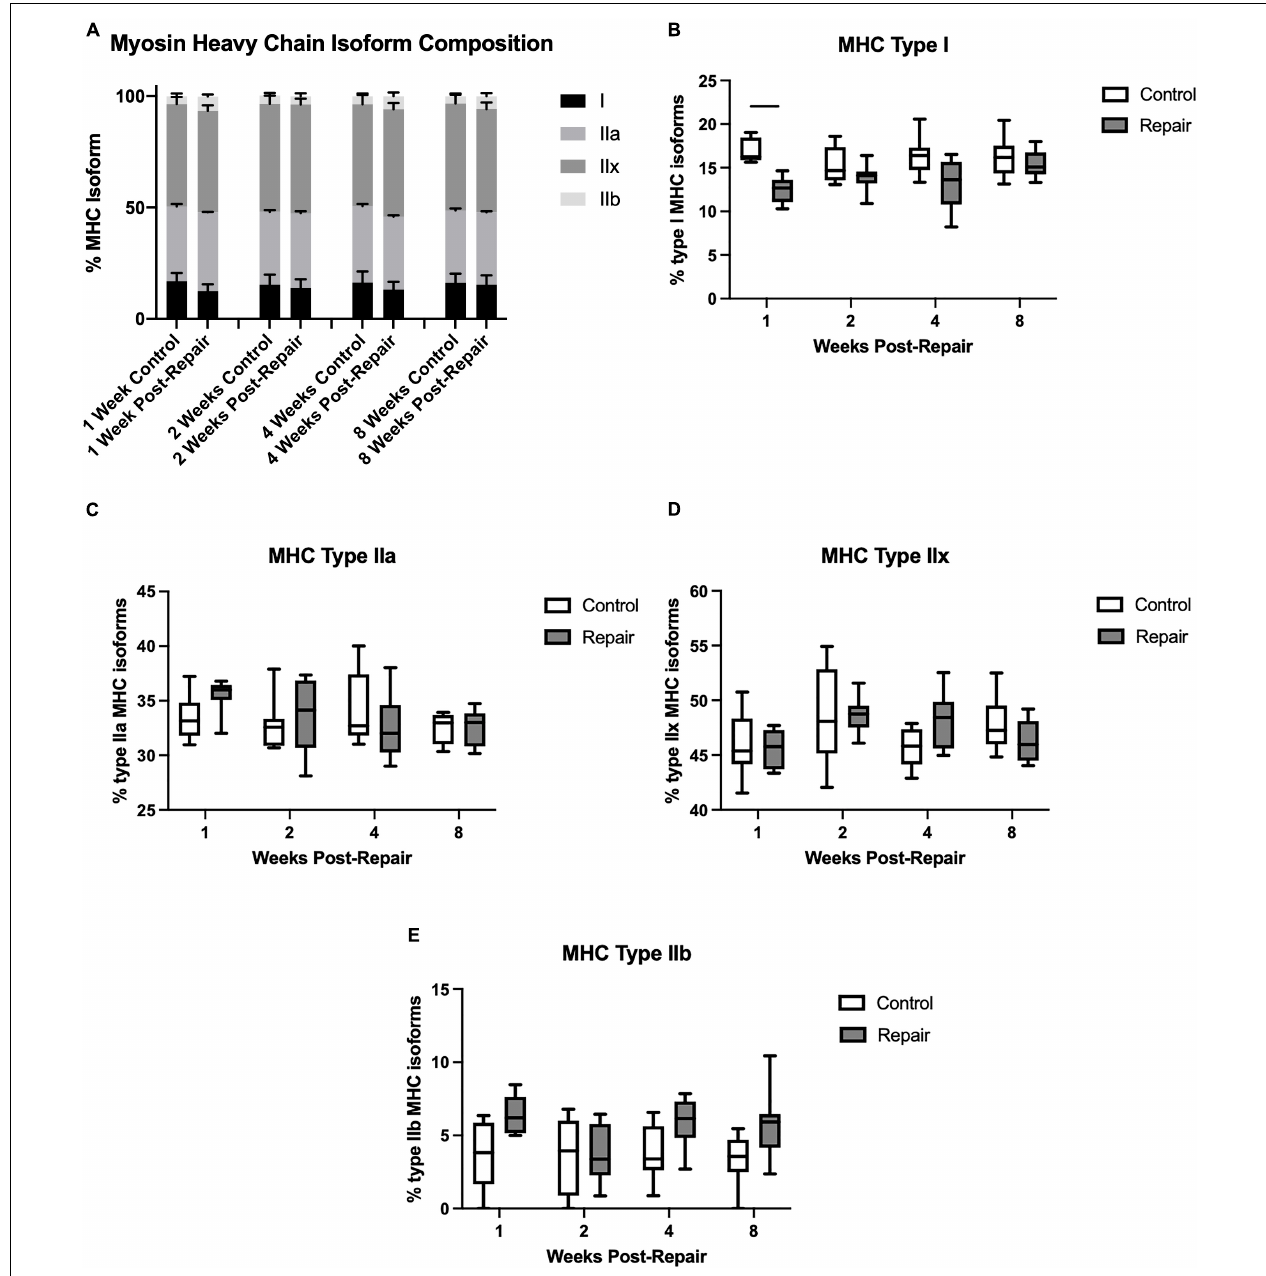
FIGURE 4 | Myosin heavy chain isoform averaged across all regions (A) . Percentage of MHC type I decreased at 1-week post-repair (B) , but type IIa (C) , IIx (D) , and IIb (E) remained unchanged. Data presented as mean ± SEM for bar graph, or minimum and maximum for box plot, N = 8 per timepoint. Significant comparisons ( p < 0.05) within timepoint or within treatment group are indicated by horizontal line. Dotted line represents historical control data from previous study (Vargas-Vila et al., 2021) at 8 weeks after tenotomy (time of